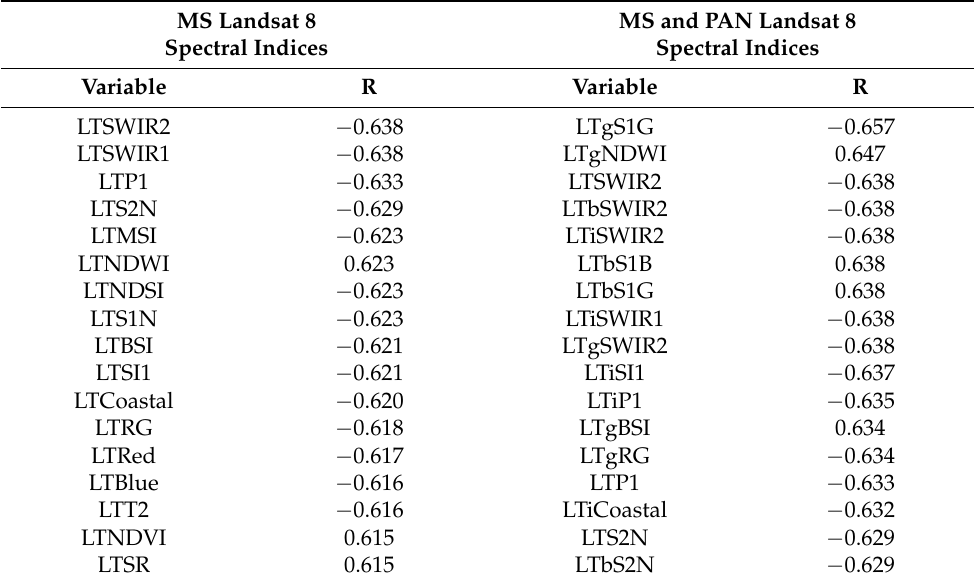
Nomenclature of the variable in Table 2: remote sensing images (abbreviation in Table S1) + spectral index (abbreviation in Table S1). Abbreviations: R, Spearman’s rank correlation